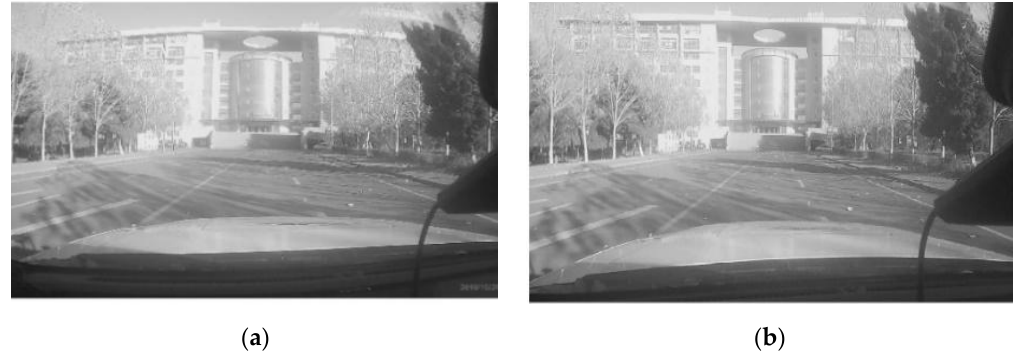
Figure 6. Image distortion correction: ( a ) original image and ( b ) image with distortion correction.